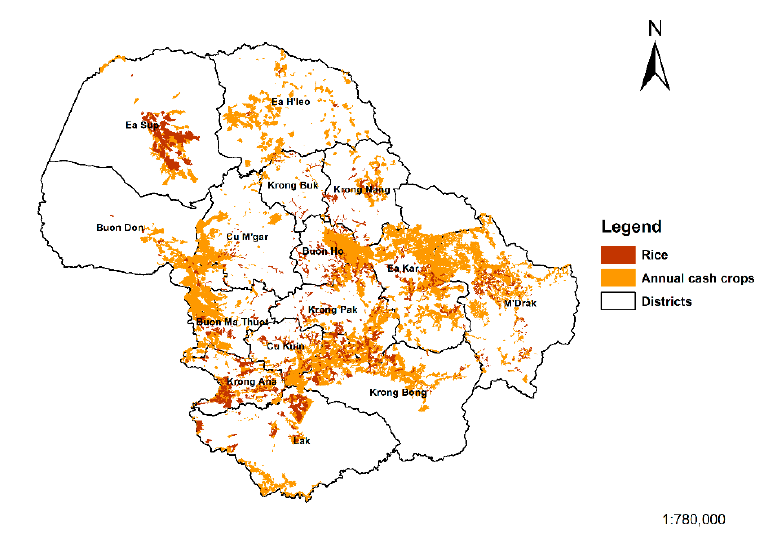
Figure 2. The 2015 official land use map.